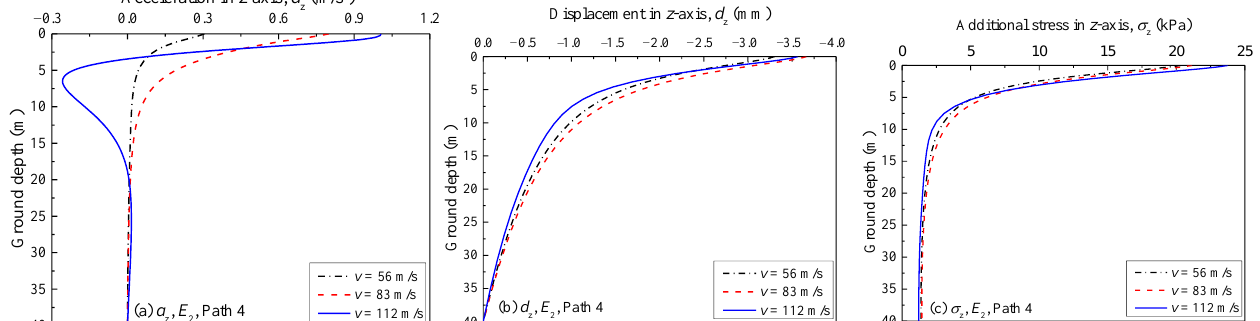
Figure 13. Variations of a z , d z , and σ z with ground depth at different speeds in Path 4: ( a ) a z ; ( b ) d z ; ( c ) σ z .